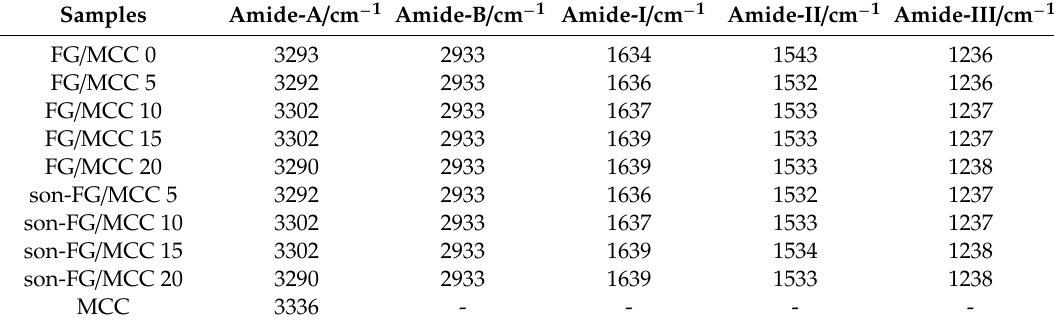
Figure 4. FTIR spectra of the FG/MCC films ( a ) and the son-FG/MCC films ( b ) treated by ultrasonic. Table 2. The Fourier-transform infrared spectra peaks of the FG/MCC composite films.